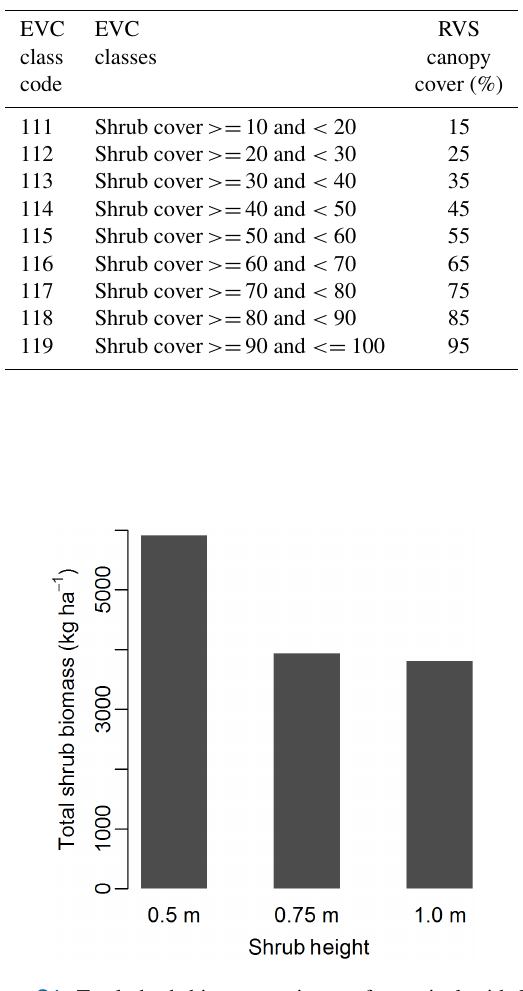
Figure C1. Total shrub biomass estimates for a pixel with EVT class of big sagebrush shrubland, EVH class of 105, and EVC class of 112 (see